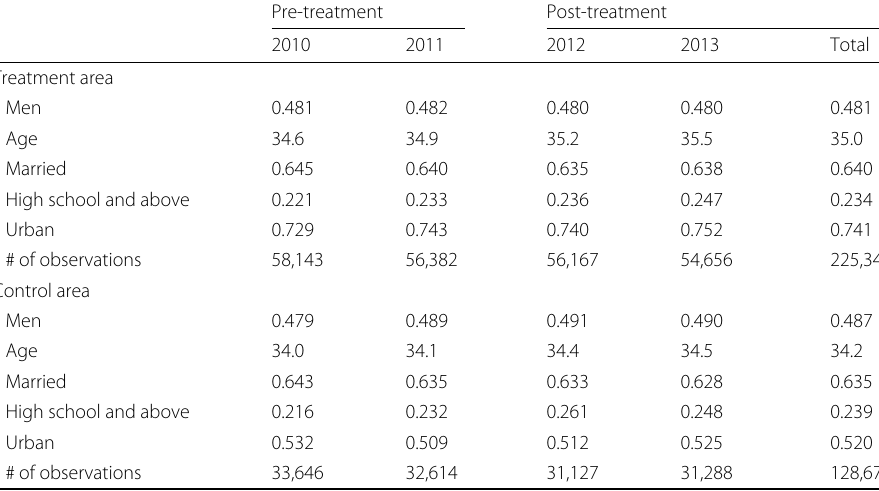
Table 3 Summary statistics: demographic characteristics for natives